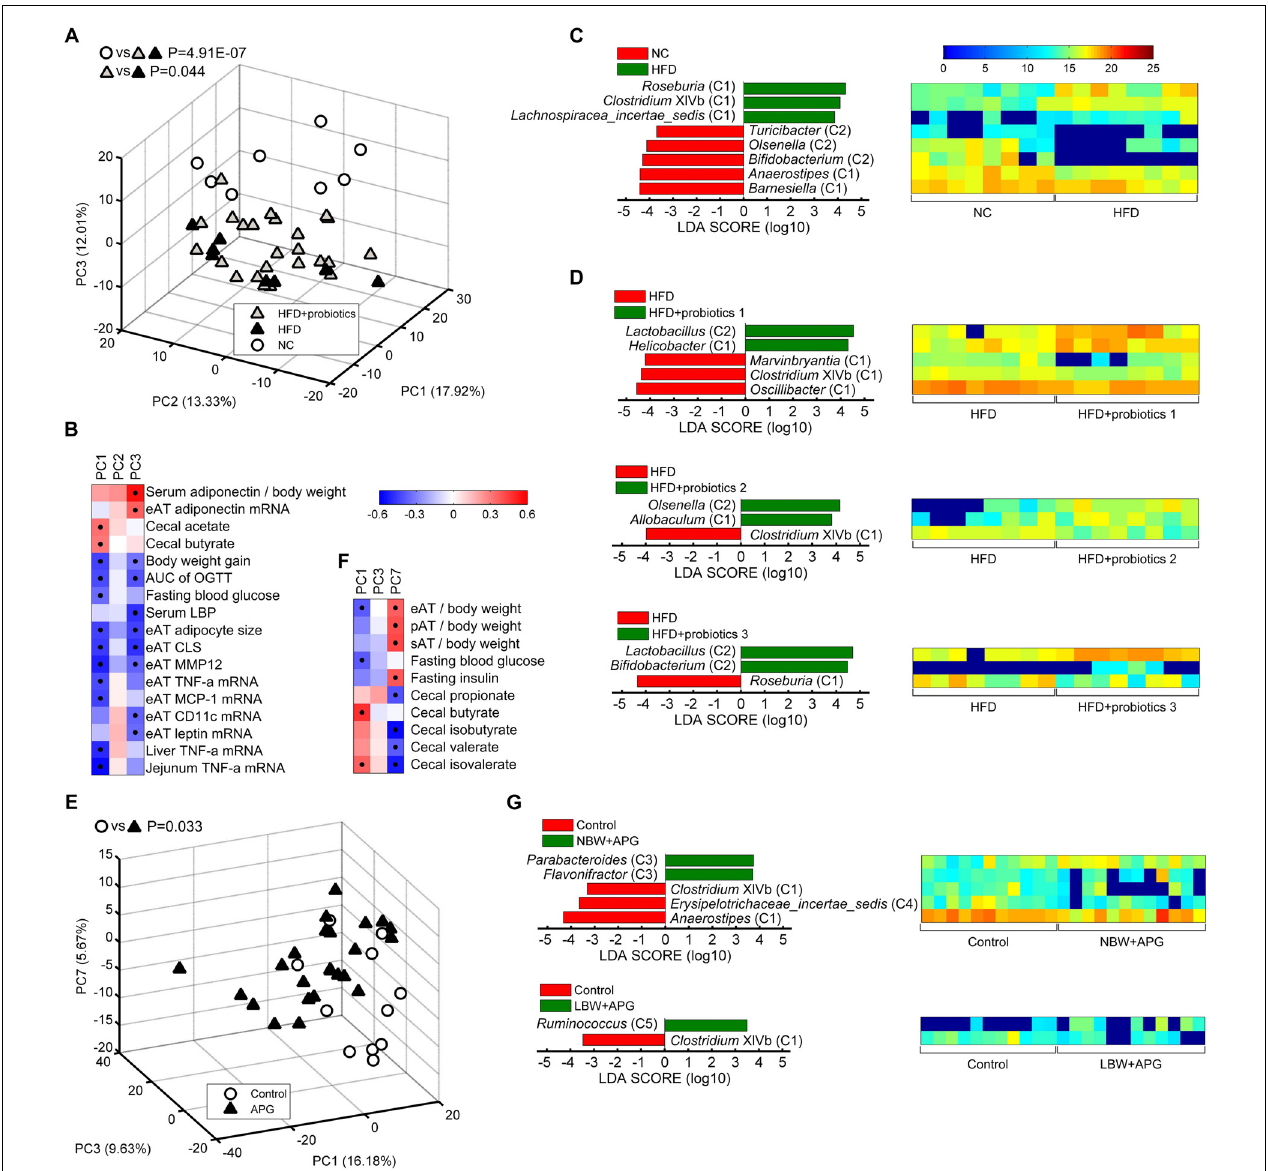
FIGURE 4 | Core bacteria significantly distinguished the gut microbial structure of healthy and disease mice. (A,E) PCA score plot was presented based on the core genus abundance of healthy and disease mice in dataset PRO (A) and CUG (E) . Each circular or triangular point represented the fecal core microbiota of a healthy or disease mouse, respectively. P -values were calculated with MANOVA test, and shown on the top of PCA plots. (B,F) Spearman correlation between core microbiota represented by the three principal components (PCs) of PCA and host disease parameters of dataset PRO (B) and CUG (F) . Columns corresponded to the three PCs, and rows to the host disease parameters. Red and blue color denoted positive and negative correlations, respectively. The color intensity represented the correlation degree. The black dots in the red/blue cells indicated the correlations were significant (false discovery rate < 0.1). (C,D,G) The different abundance of bacterial genus between two groups was identified by LEfSe. It was significantly different when alpha value of the factorial Kruskal–Wallis test was < 0.05 and the logarithmic LDA score was > 2.0. The left histogram showed LDA scores of differentially abundant genera between the two groups. The taxonomy was listed, followed by its core group. The right heatmap showed the relative abundance (log 2 transformed) of differential genera. n = 8 for NC, HFD, HFD+probiotics 1, HFD+probiotics 2, and HFD+probiotics three groups ( n = 24 for HFD+probiotics group in total); n = 12 for Control, NBW+APG, LBW+APG groups ( n = 24 for APG group in